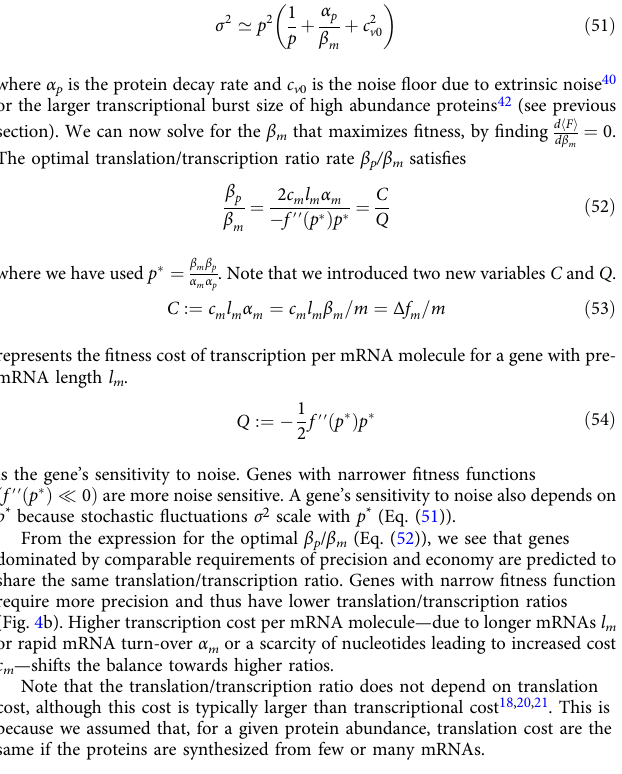
where σ 2 is the variance of protein abundance fl uctuations (Fig. 4a). The f ′′ p (cid:2) ð Þ σ 2 , is the noise load Δ f noise , the fi tness curvature times this variance, (cid:3) 1 2 lost due to the stochastic fl uctuations in protein abundance 24,25 (Fig. 4a). It is a positive quantity because the curvature f ″ ( p ) is negative at the maximum p = p * . We seek the transcription rate β m that maximizes fi tness. For this purpose we note that β m affects the noise level σ 2 in a well-characterized way. Theory and experiments of gene expression noise 15 – 17,40 indicate that variance of protein noise is given by